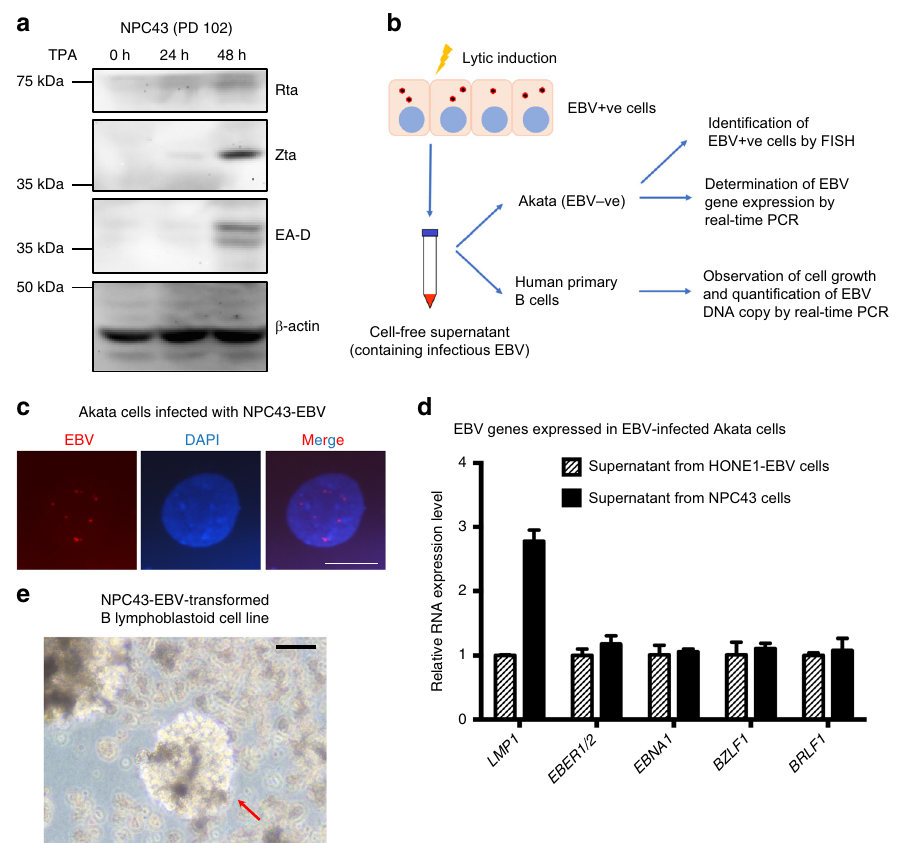
Fig. 5 Production of infectious virus by NPC43 upon EBV lytic reactivation. a Expression kinetics of Rta, Zta and EA-D proteins in NPC43 cells upon TPA treatment. Expression of β -actin was included as the loading control. b The schematic diagram showing the work fl ow to determine whether infectious EBV particles were present in the supernatant of EBV + ve cells (including NPC43 and HONE1-EBV) upon lytic induction. Brie fl y the EBV + ve cells were induced to undergo lytic EBV reactivation. The cell-free supernatant which contains the infectious EBV was collected and was used to infect EBV – ve Akata cells or human primary B cells. The presence of EBV virions was con fi rmed by the respective experiments listed. c Identi fi cation of EBV + ve Akata cells by FISH analysis. The supernatant of NPC43 upon EBV lytic induction was collected for co-culture with EBV – ve Akata cells. At 96 h after co-culture, part of the infected Akata cells were subjected to FISH analysis. The presence of EBV genome was indicated by punctate red dots in Akata cell nucleus. Scale bar, 10 μ m. d Determination of EBV gene expression by real-time PCR analysis in EBV-infected Akata cells. The supernatant collected from NPC43 or HONE1-EBV cells were subjected to co-culture with EBV – ve Akata cells for 96 h. EBV gene expression was evaluated afterwards. Akata cells infected by EBV from NPC43 cells after TPA treatment had a comparable level of EBV RNA expression with that from HONE1-EBV cells. Data are shown as mean ± SD from three independent experiments. e Proliferating foci of human primary B cells infected by NPC43-EBV after 28-day culture. Arrow suggests an